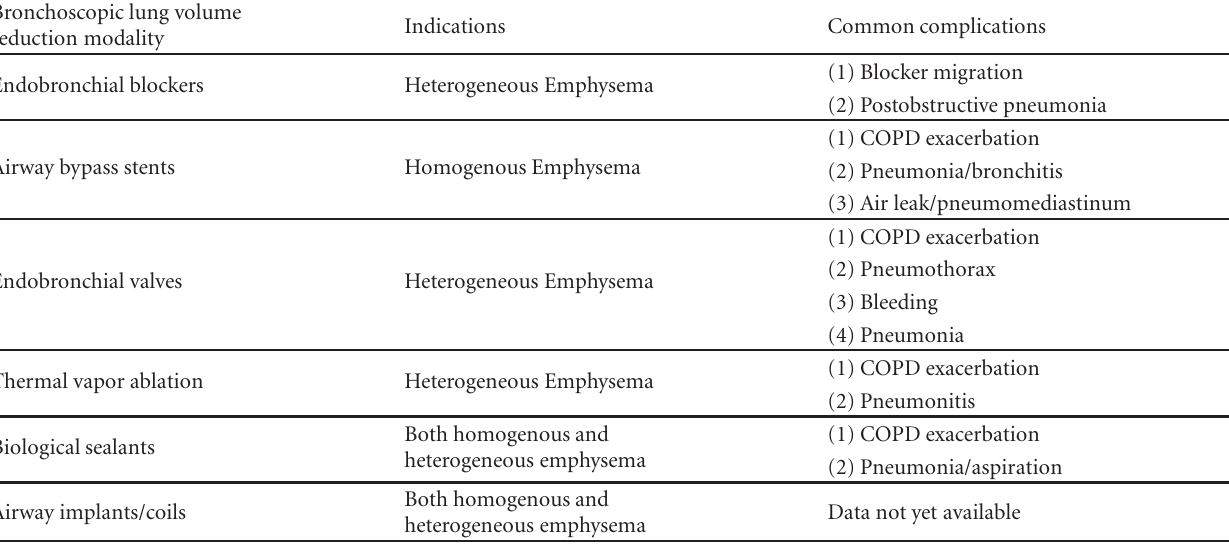
Table 1: Bronchoscopic lung volume reduction modalities with their indications and commonly encountered complications. Bronchoscopic lung